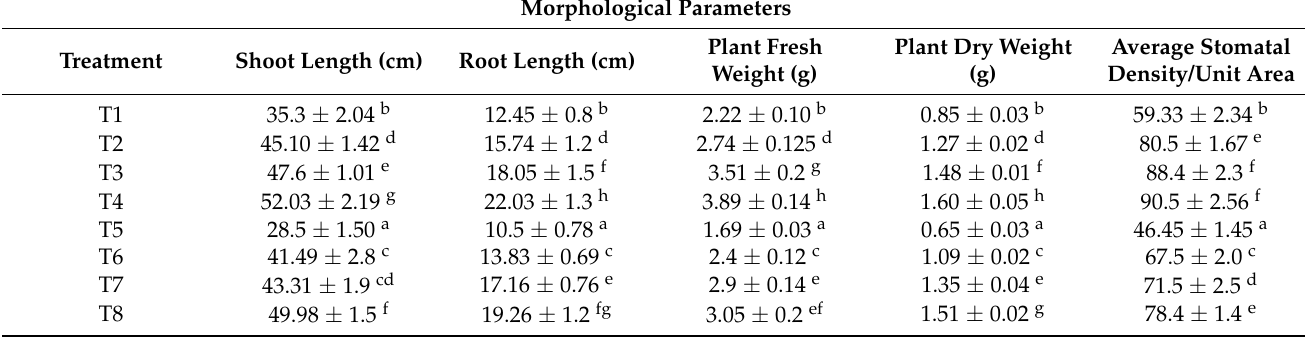
Table 2. Effect of inoculation of drought-tolerant bacterial endophytes on morphological parameters of soybean seedlings grown under well-watered and drought stress